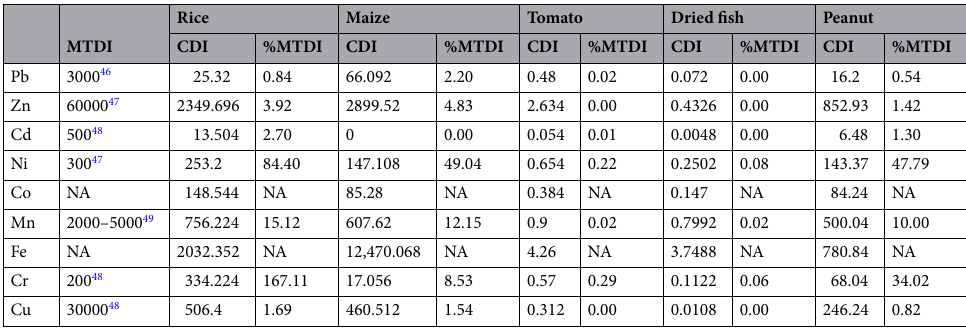
Table 3. Chronic daily intake and contribution to the maximun tolerable daily intake (ug/day). NA: not